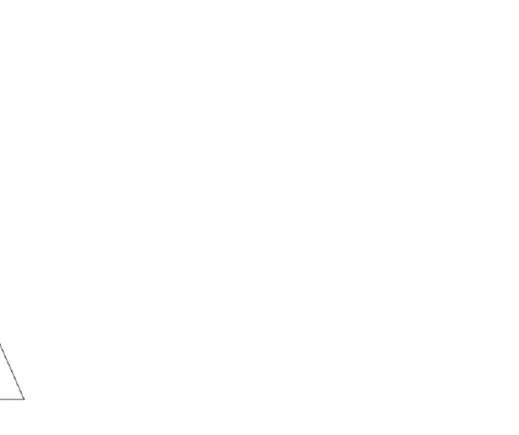
Figure 11. Schematic diagram of analytical